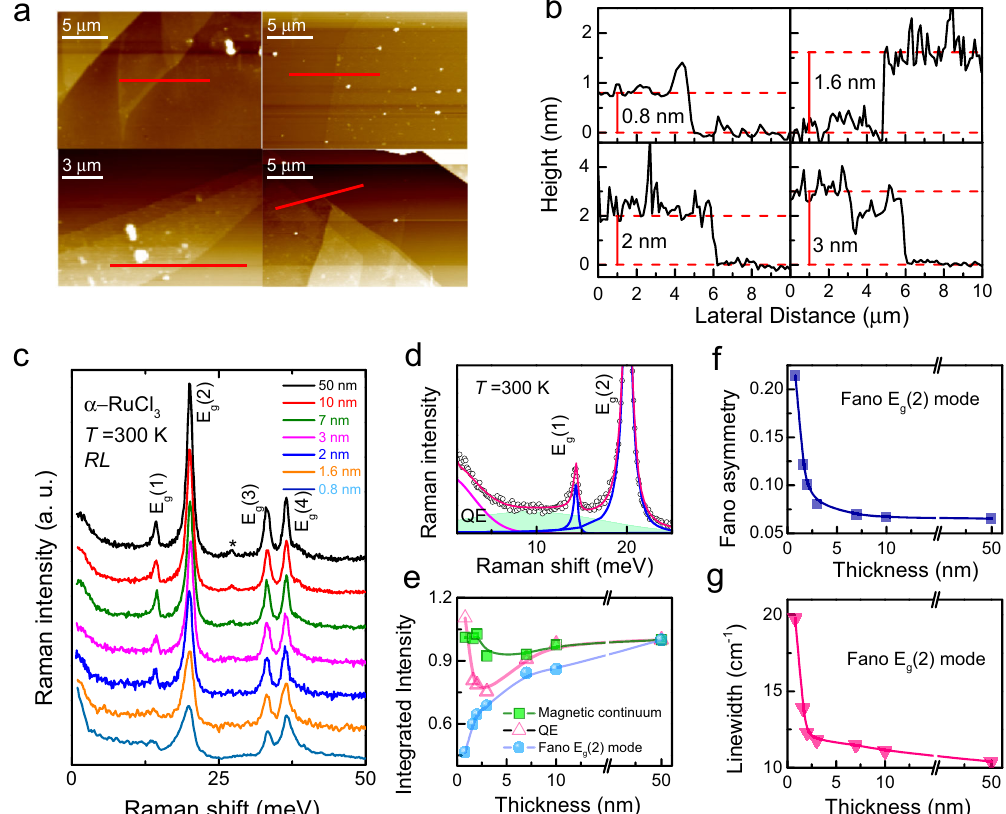
Fig. 1 Atomic force microscope (AFM) images and Raman spectra of the exfoliated α -RuCl 3 fl akes. a Representative AFM images of the exfoliated nano fl akes. b Height pro fi les of the nano fl akes along the red lines shown in a . c Thickness dependence of the Raman spectra measured at T = 300 K in RL polarization. Four major phonons are assigned to E g symmetry. The asterisk denotes a symmetry-forbidden mode. The spectra are vertically shifted for clarity. d Representative fi t of the low-energy Raman spectrum to a sum of two Gaussian and two Fano resonances. The green shading denotes a background magnetic continuum, which is thermally damped. e Thickness dependence of the integrated intensities of the E g (2) Fano phonon (cyan balls), the quasielastic response (open triangles), and the thermally damped magnetic continuum (green squares). f , g Thickness dependence of the Fano asymmetry and linewidth for the E g (2) Fano mode. The solid colored lines represent guides to the